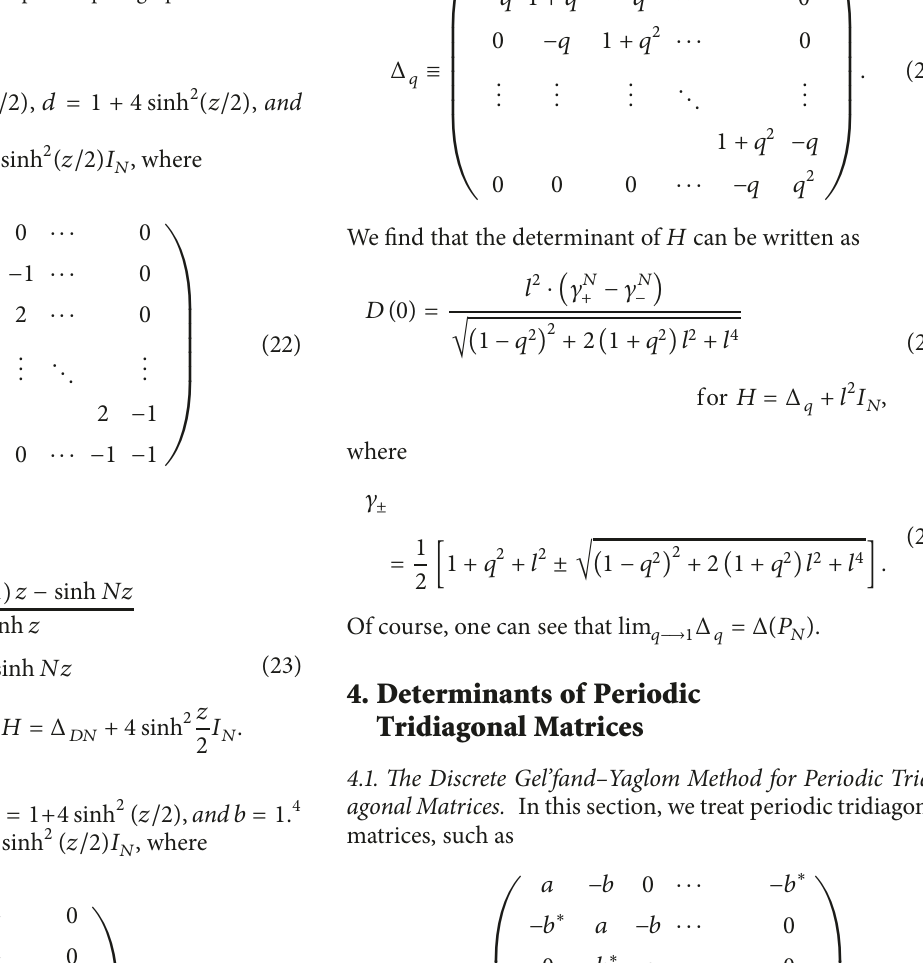
Figure 1: 𝑃 8 as an example of a path